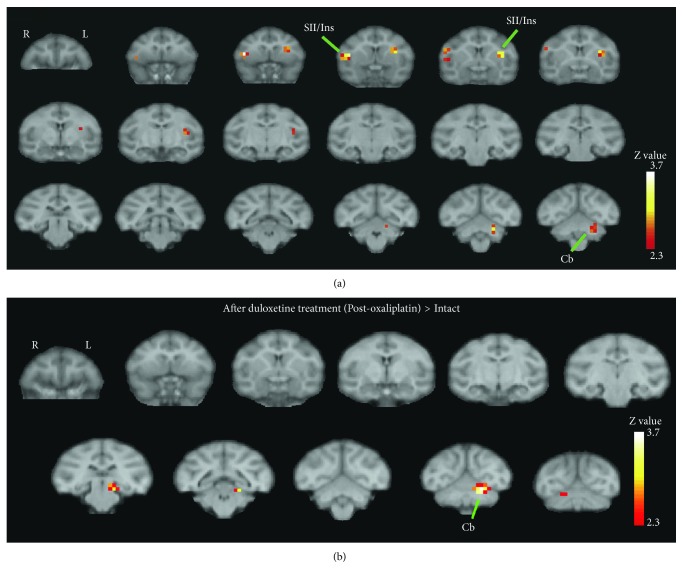
Cold stimulation evokes brain activation in oxaliplatin-treated macaques, which is attenuated with duloxetine. Before and three days after oxaliplatin treatment, brain activation was visualized with a 3.0 T Philips Healthcare MRI system in propofol-sedated macaques [42]. Alternating temperatures (cold, 10°C and neutral, 37°C) were applied to the tail for 30 sec. each with a 30 sec. interval without stimulation. (a) Cold stimulation in oxaliplatin-treated macaques activated secondary somatosensory cortex (SII) and insula (Ins). Activation in the left cerebellum (Cb) following cold stimulation was also observed. Contrast was defined as (10°C stimulation −37°C stimulation after oxaliplatin treatment)–(10°C stimulation −37°C stimulation before oxaliplatin treatment; “intact”). Peak voxels Z values greater than 3.0 were p < 0.001 (uncorrected for multiple comparisons, one-tailed). Coronal sections of oxaliplatin-treated macaques averaged from four macaques. Sections arranged from rostral (upper left) to caudal (lower right) and spaced 2 mm apart. R, right; L, left. (b) Duloxetine suppressed cold-induced activation in SII and Ins in oxaliplatin-treated macaques. However, activation in Cb was still present following duloxetine treatment. Three days after oxaliplatin treatment, macaques were dosed with duloxetine (p.o. 30 mg/kg) and cold-evoked brain activation was measured one hour following duloxetine treatment. The effect of duloxetine treatment on cold-evoked brain activation in oxaliplatin-treated macaques (“after duloxetine treatment (Post-oxaliplatin)”) was compared to cold-evoked brain activation before oxaliplatin treatment (“intact”). No significant activation in SII and Ins was observed following duloxetine treatment (p > 0.05). Thus, the lack of activity in SII and Ins following duloxetine administration in oxaliplatin-treated macaques was similar to that of macaques prior to oxaliplatin treatment. (An additional analysis was performed comparing cold-evoked SII and Ins activation after and before duloxetine treatment in oxaliplatin-treated macaques (data not shown, [42]). Activation in SII and Ins following duloxetine treatment was significantly suppressed—the difference in peak voxels, between after and before duloxetine treatment, was p < 0.001. See [42] for details.) Coronal sections of oxaliplatin-treated macaques averaged from four macaques. Sections arranged from rostral (upper left) to caudal (lower right) and spaced 4 mm apart. R, right; L, left. Data previously published in [42].